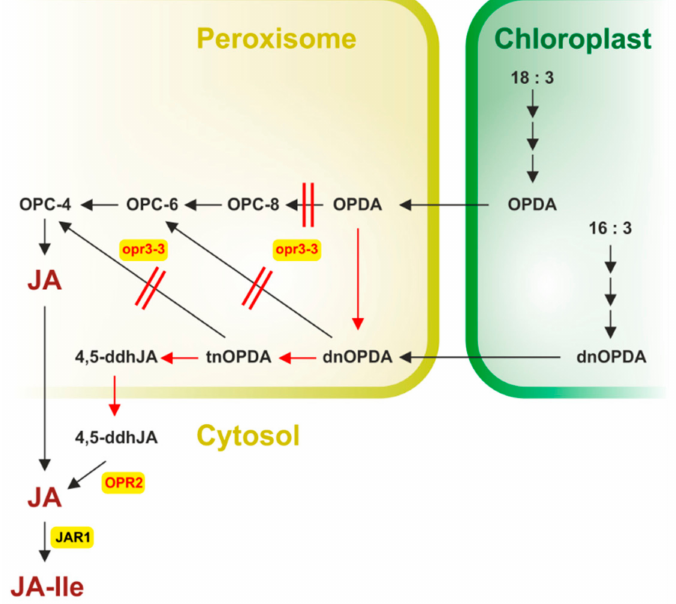
Figure 2. The bypath in JA biosynthesis. OPDA and dnOPDA are formed in chloroplasts and converted to JA and 4,5-ddh-JA, respectively, in peroxisomes. In opr3-3 plants, peroxisomal OPDA is metabolized to dinor-OPDA (dnOPDA), tetranor-OPDA (tnOPDA) and 4,5-didehydro-JA (4,5-ddh-JA), which is reduced to JA by OPR2 after release into the cytosol. Black arrows show the canonical pathway, red arrows highlight the new pathway identified in opr3-3 plants. Red parallel lines indicate block in the conversion of OPDA and dnOPDA within the opr3-3 mutant. The newly identified property of OPR2 in opr3-3 is marked in red (redrawn based on Reference [102] with